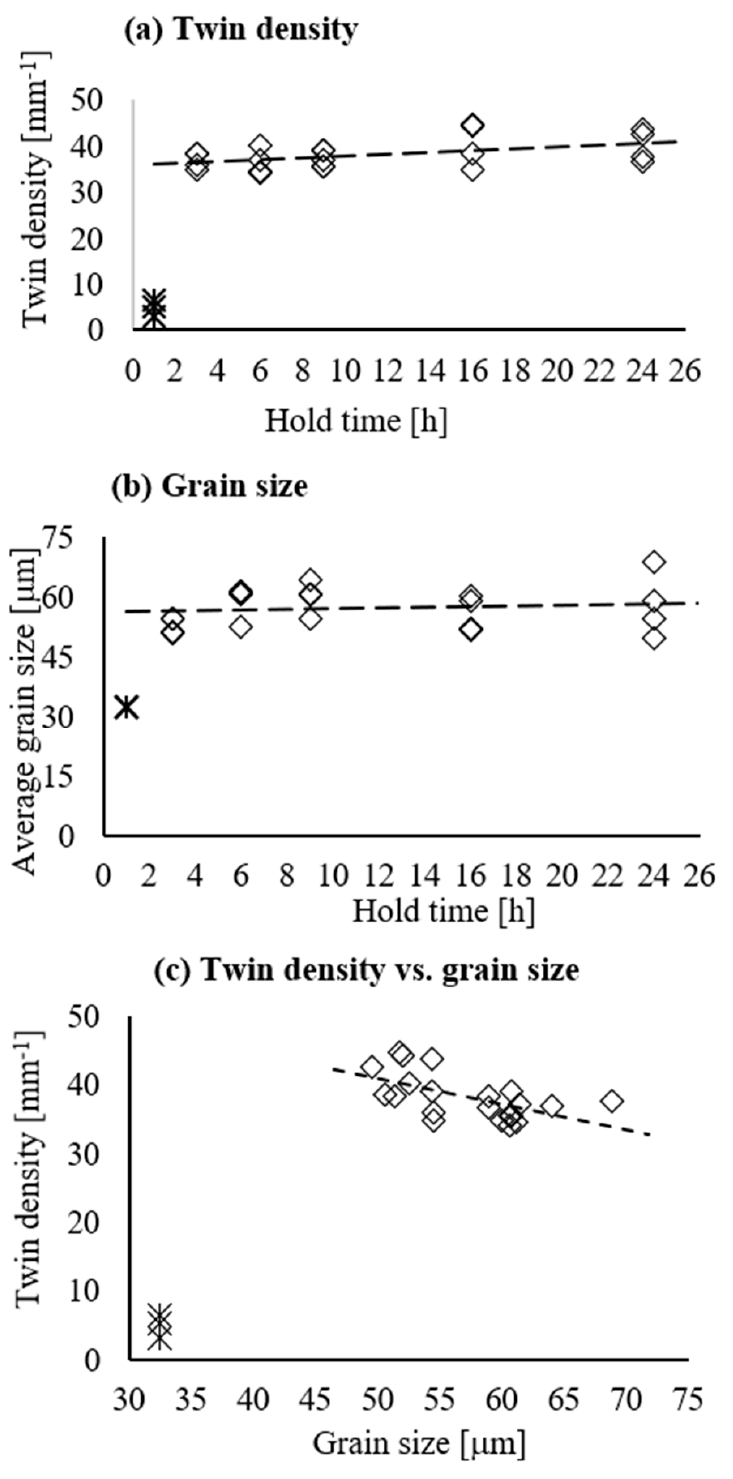
Figure 5. Annealing twin density ( a , b ) average grain diameter as a function of the hold time and ( c ) twin density vs. grain size.